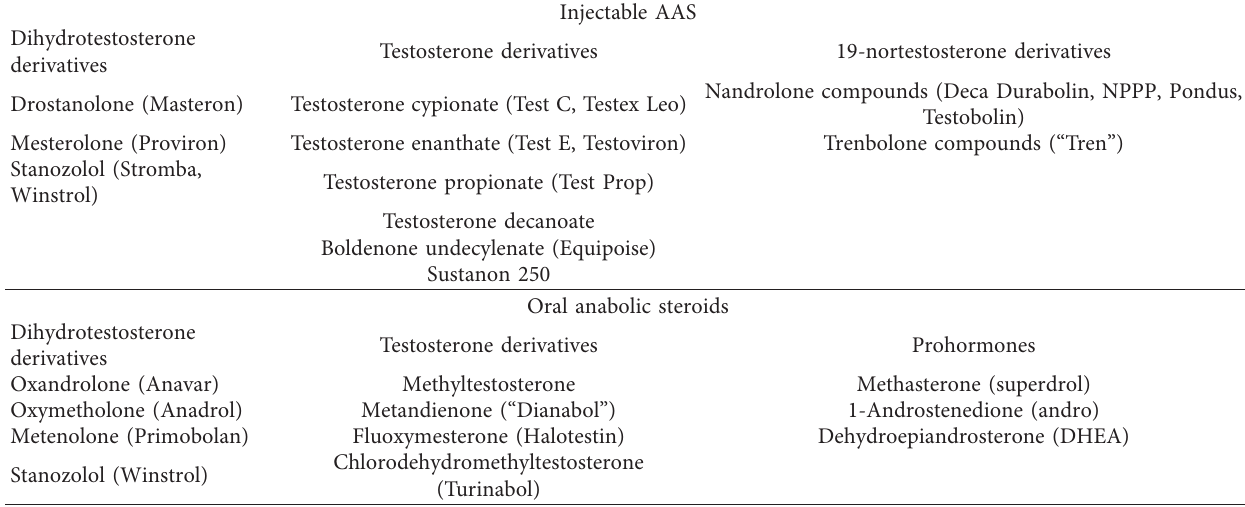
Table 1: An overview of selected injectable and oral anabolic steroids.